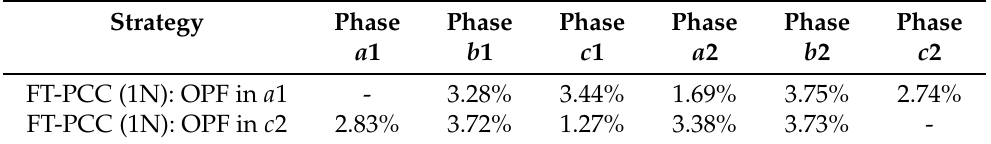
Table 4. Experimental results: current THD for fault-tolerant mode due to an OPF in phases a 1 and c 2 at 1200